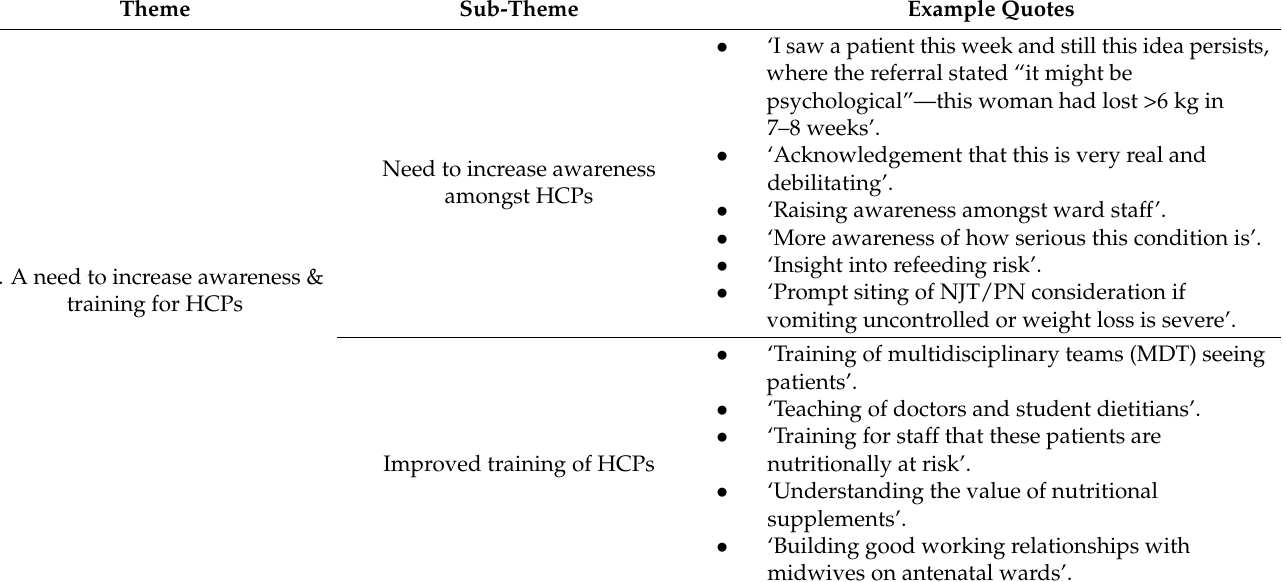
Table 2. Themes from responses to question: ‘What would help optimise the referral rate and dietetic management of pregnancies with HG?’